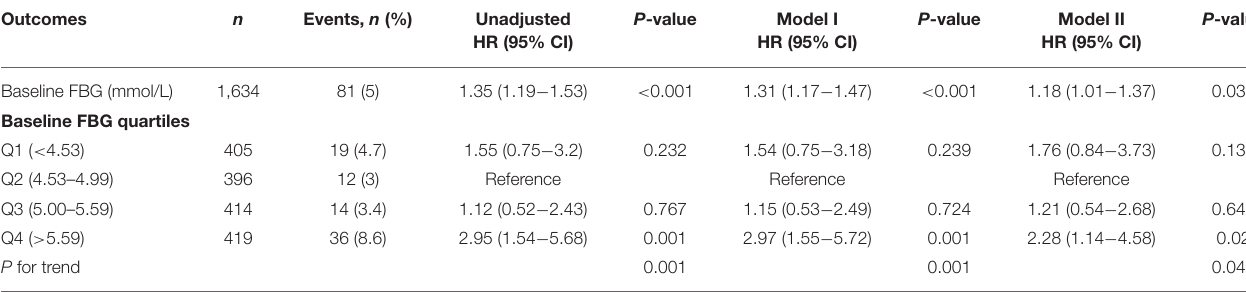
TABLE 2 | The relationship between baseline FBG and 1-year stroke recurrence in non-diabetic patients with ACI. Outcomes